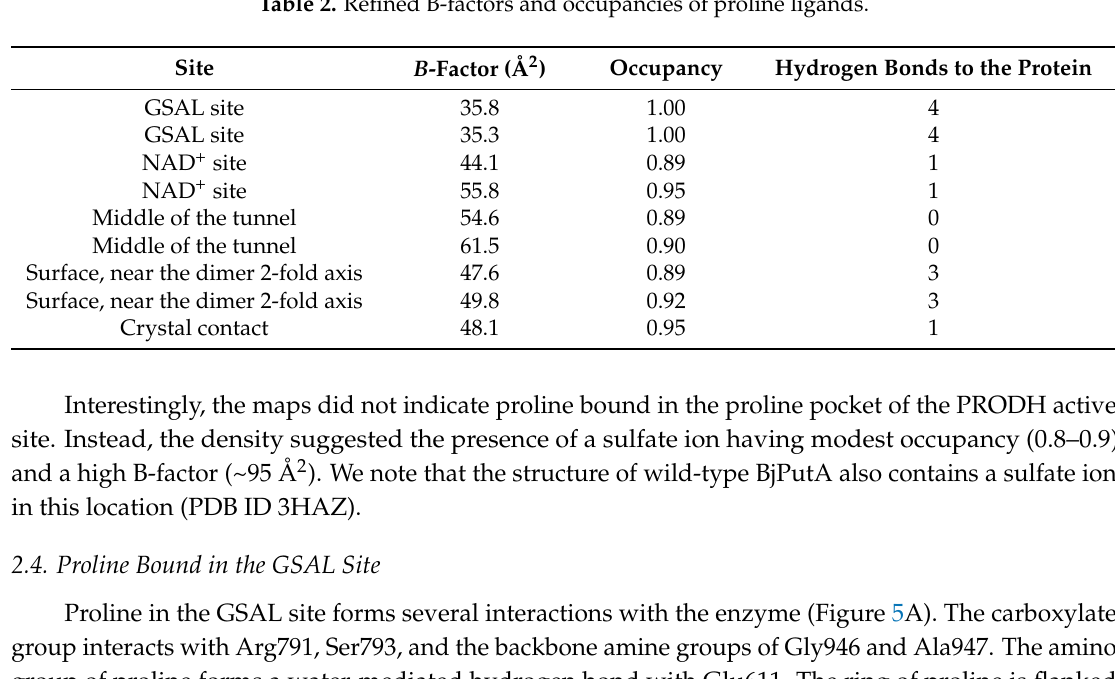
Table 2. Refined B-factors and occupancies of proline ligands.